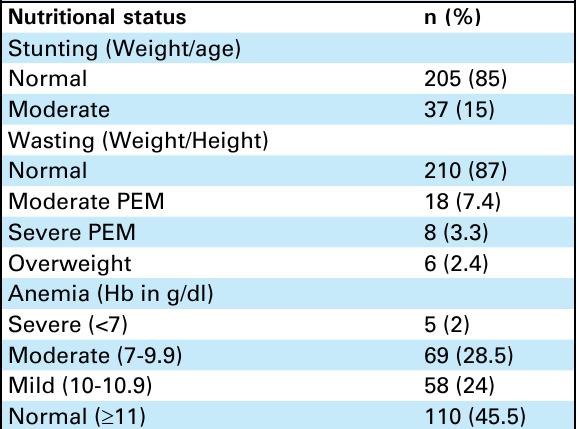
Figure 2. Gender Distribution (n= 660). Stunting and wasting were seen in 37 (15%) and 26 (10.7%) of children while 6 (2.5%) of them were found overweight. Anemia was observed in almost 132 (54.5%) of the children, most of which were mild to moderate in severity (Table 2). Table 2. Nutritional Profile of Under five children admitted in the Hospital with ARI